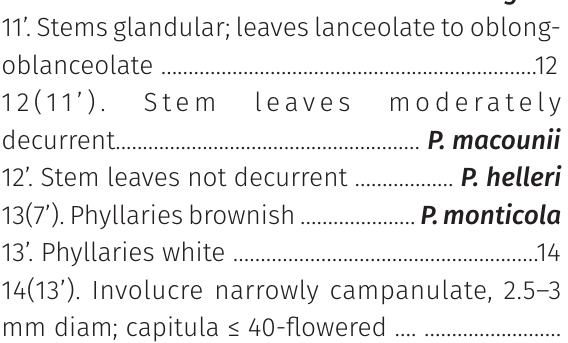
9(8). Phyllaries acute ………………… P. austrotexanum 9’. Phyllaries obtuse to rounded ....……………………..10 10(9’). Phyllaries shiny; pistillate florets 200–400; 10’. Phyllaries opaque; pistillate florets ≤ ca. 125;